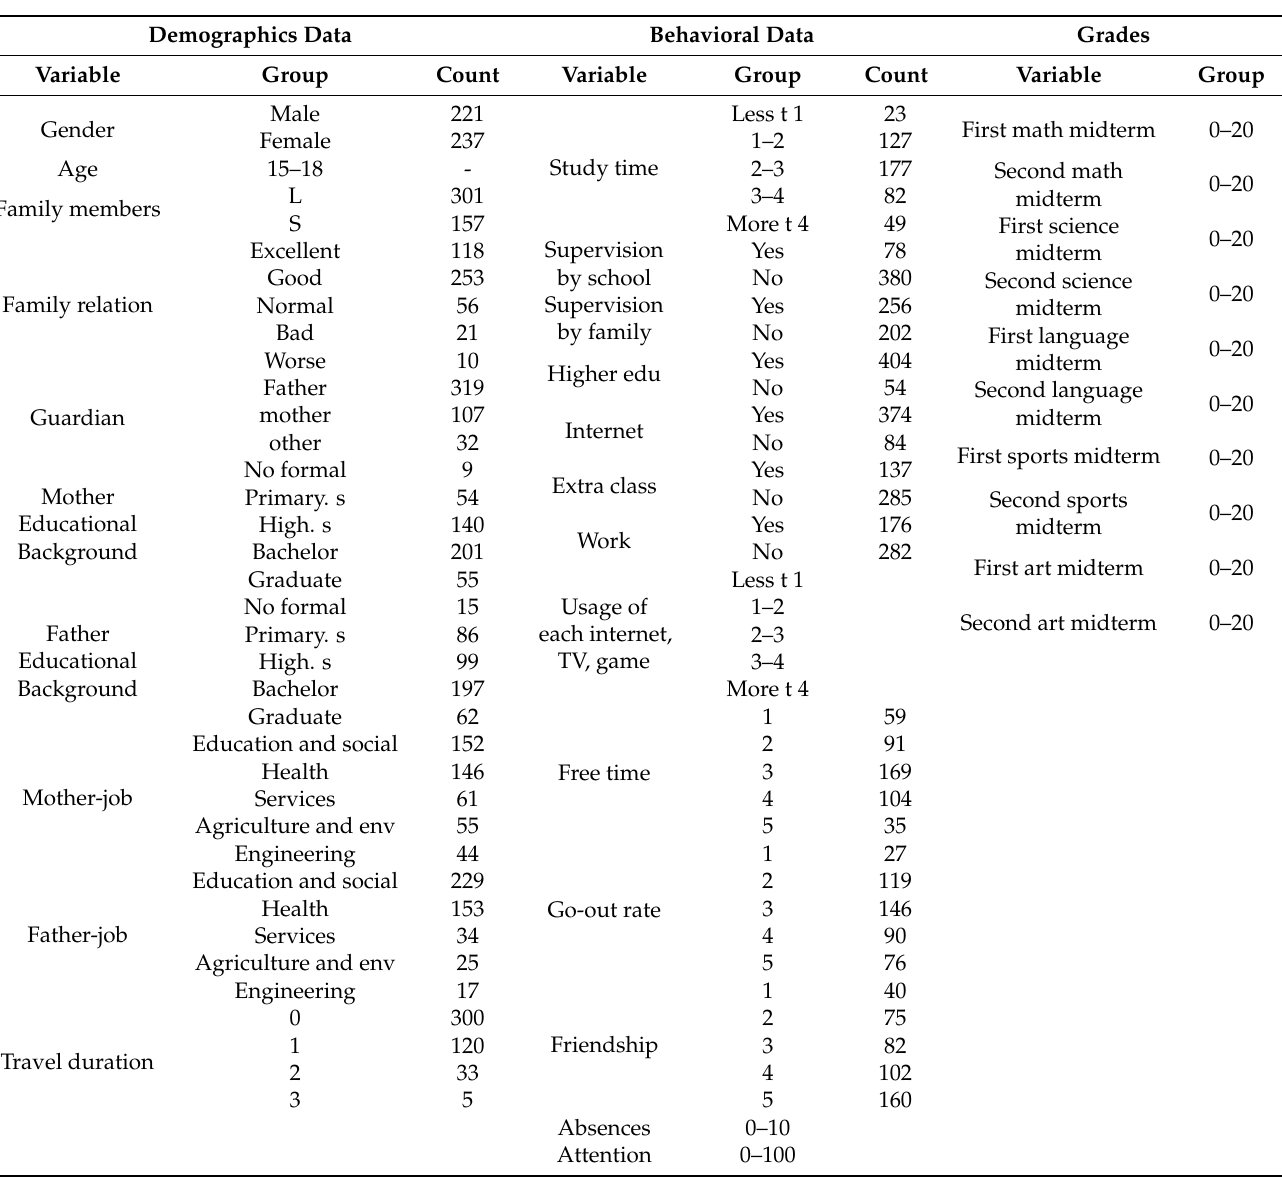
Table 1. Attributes of the database with value